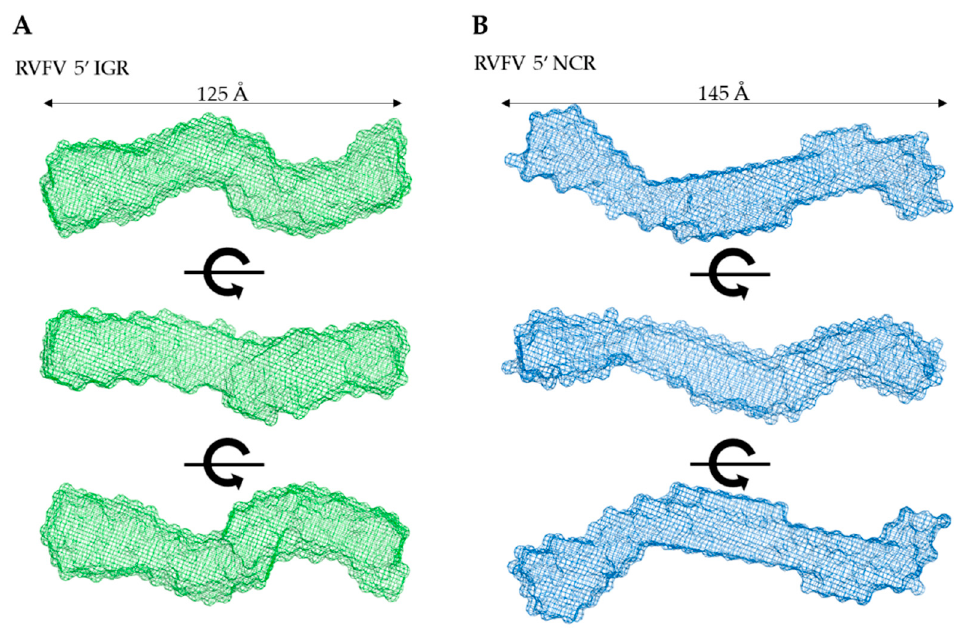
Figure 4. Low-resolution structure determination via SAXS for RVFV 5’ NCR and RVFV 5’ IGR, indicating that these RNA molecules adopt an extended solution structure. ( A , B ) Three structures representing sequential 90° rotational angles from the top panel structure. Dimensions represent the D max obtained from P(r) analysis. Table 1. Solution properties of DDX17 135–555 , IGR, and 5’ NCR.